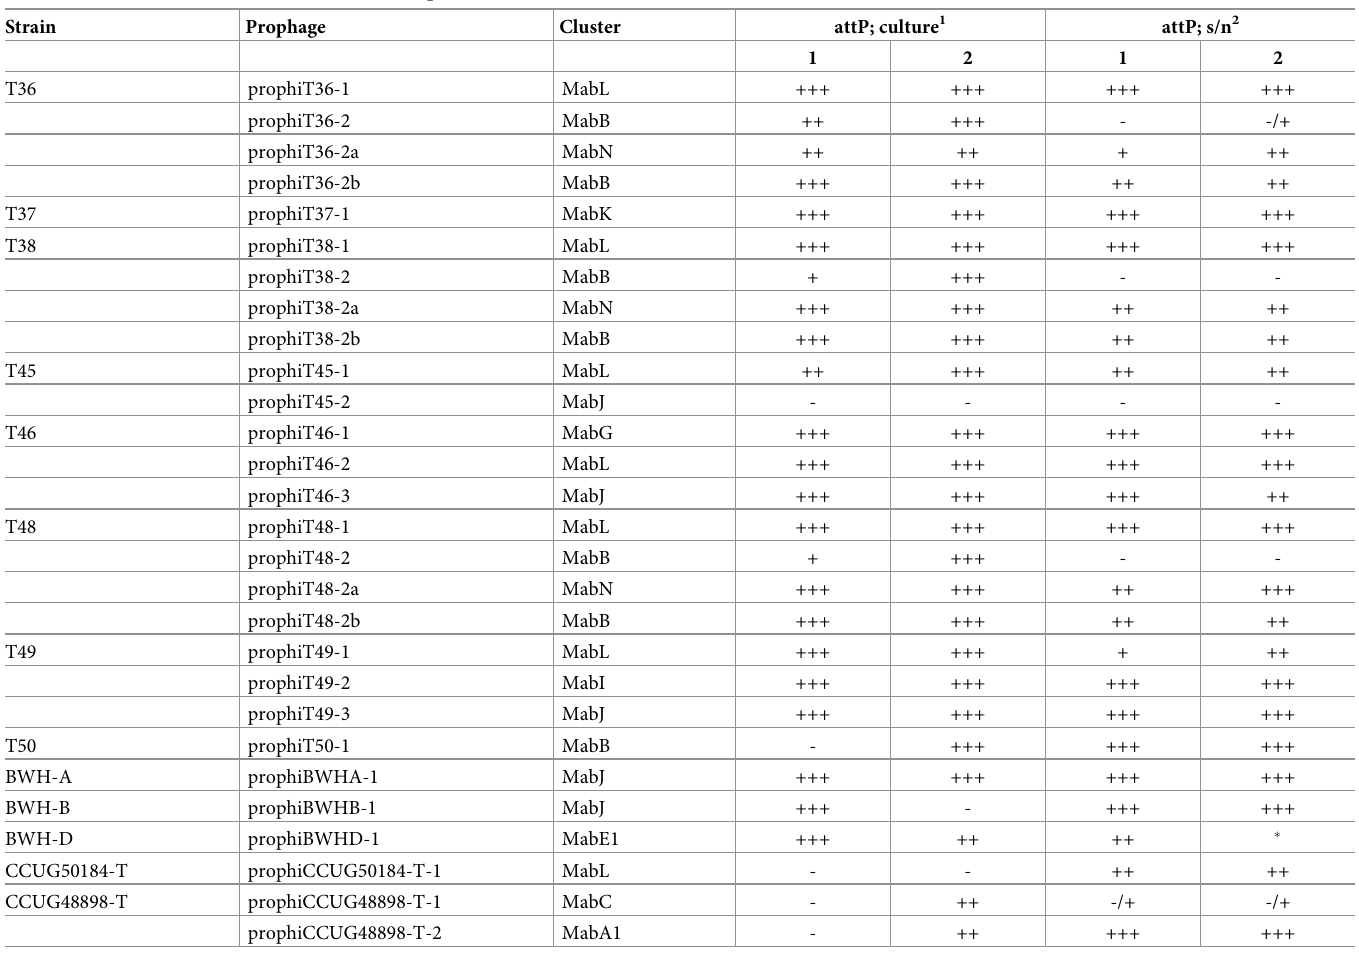
Table 3. Presence of attP in cultures and culture